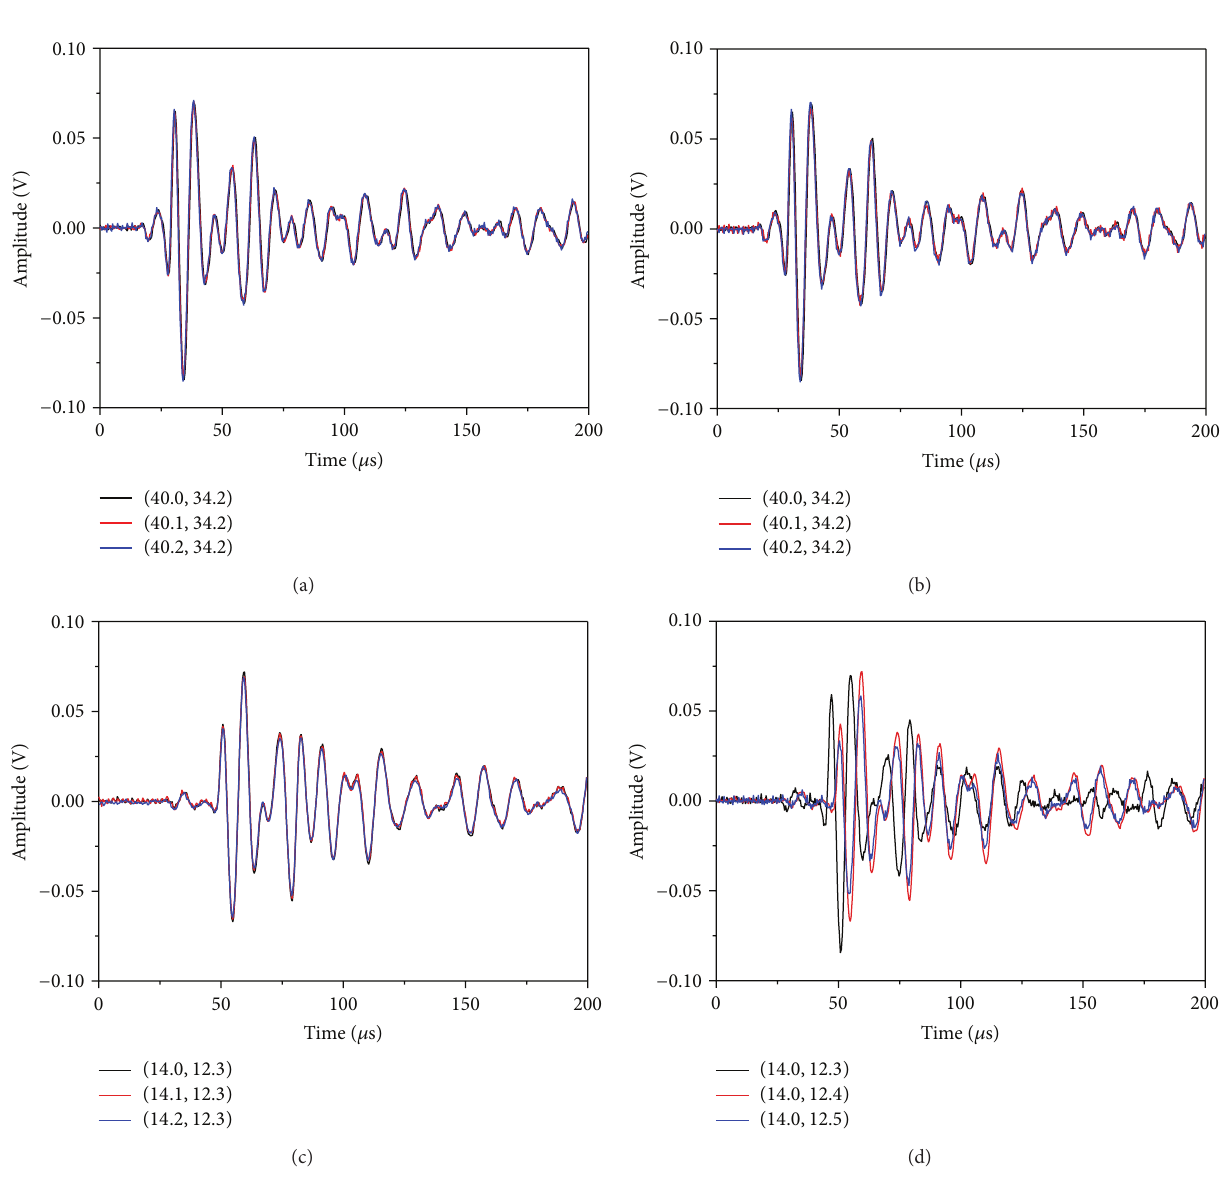
Figure 7: Similarities of three adjacent signals along (a) 𝐻 -axis, (b) 𝑉 -axis at an intact surface position, (c) 𝐻 -axis, and (d) 𝑉 -axis at the surface crack